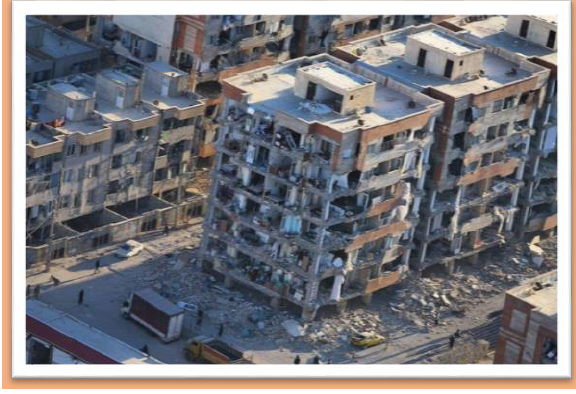
Figure 4: Mehr Housing in Neyshaboor (URL